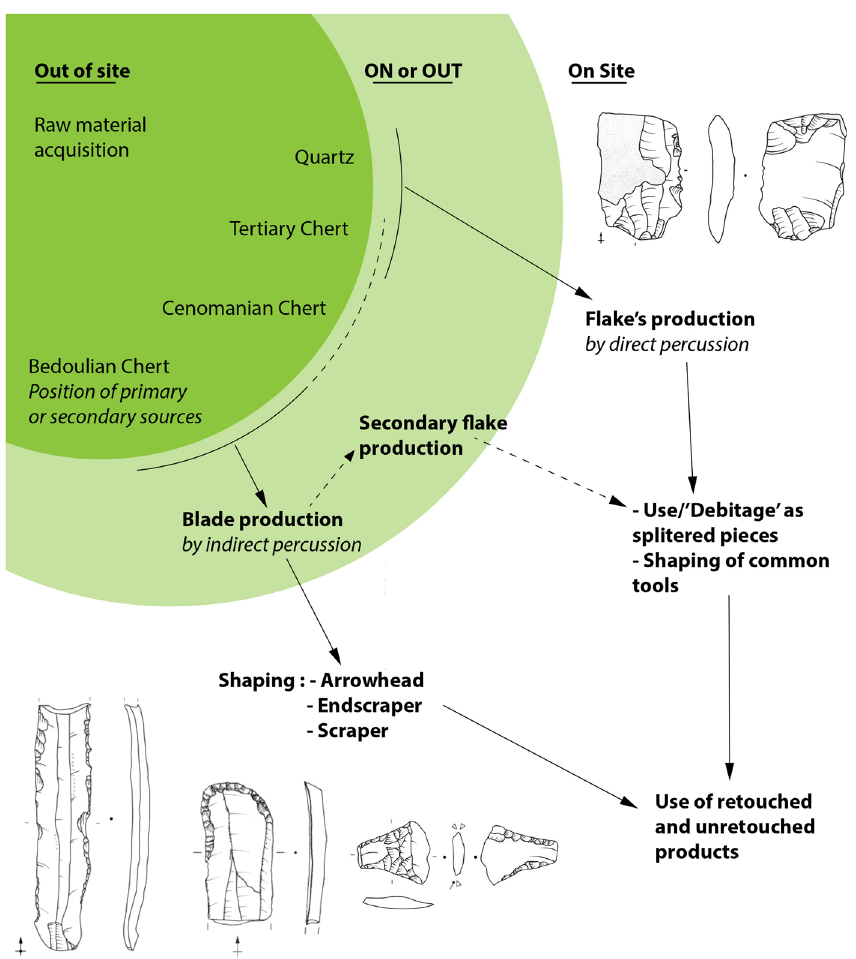
Figure 4: Recurrent operative pattern for Cardial and Epicardial lithic productions from the Lower Rhône